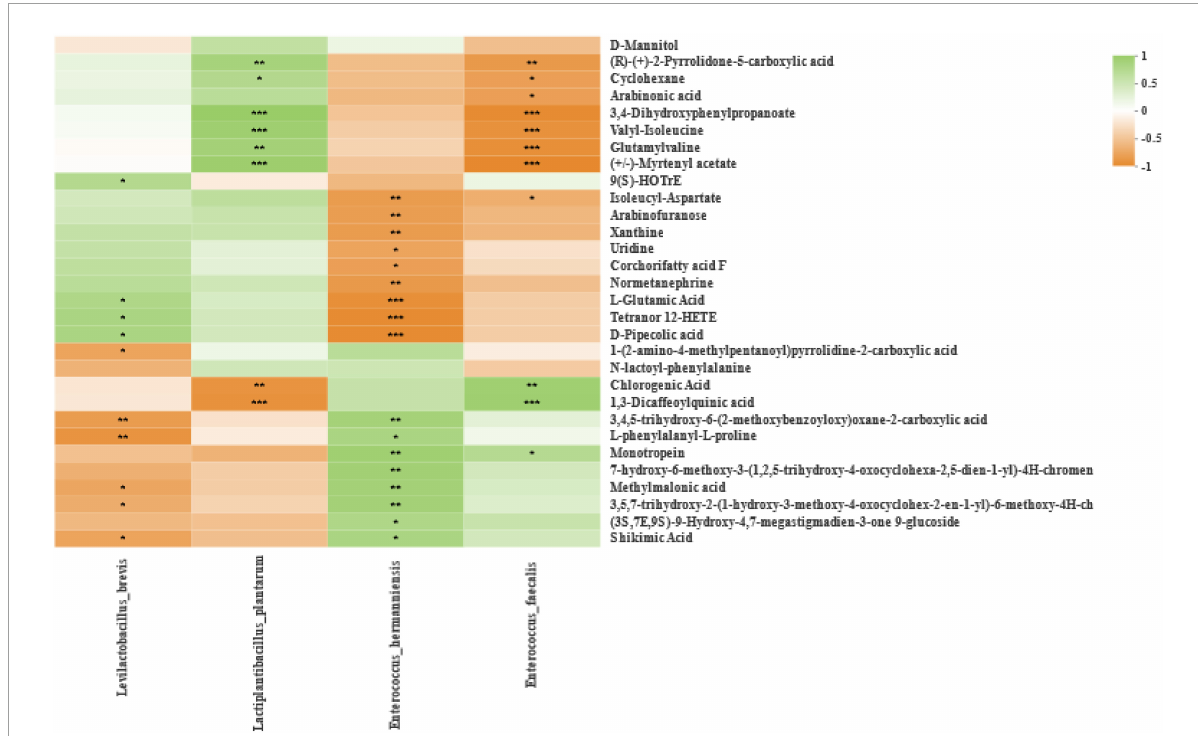
FIGURE7 Correlation analysis of the high abundance of species-level bacteria and metabolites in silage from different harvests. * p < 0.05, ** p < 0.01, and *** p < 0.001, respectively.